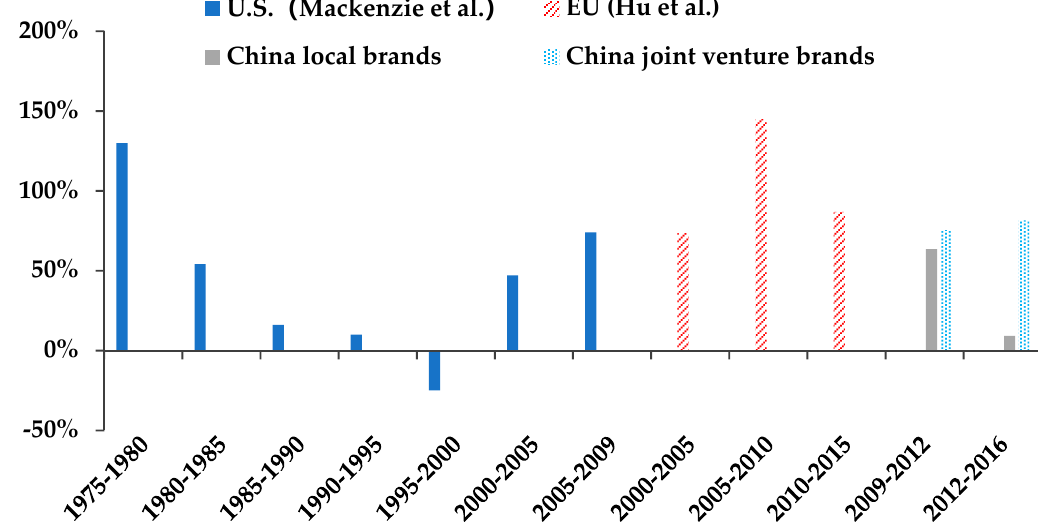
Figure 7. Comparisons of Emphasis on Reducing Fuel Consumption (ERFC) between the U.S., EU, and China.